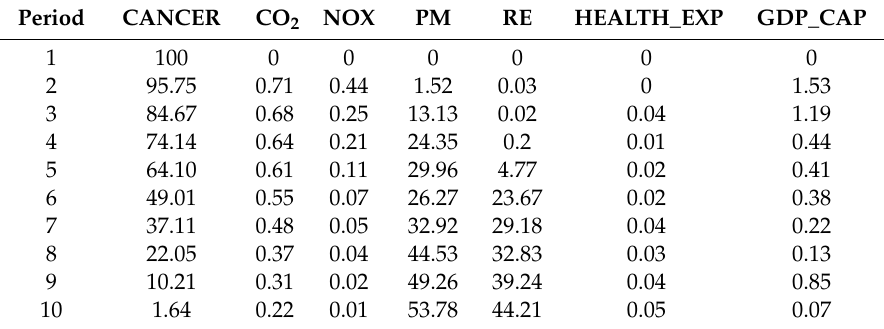
Figure 4. Accumulated response of CANCER to Cholesky one S.D. innovations. Note: Vertical axis is accumulated response of CANCER to Cholesky one standard deviation innovations, Horizontal axis is period of time. Source: Authors’ compilation from Eviews 10.00. Table 7. Variance decomposition of